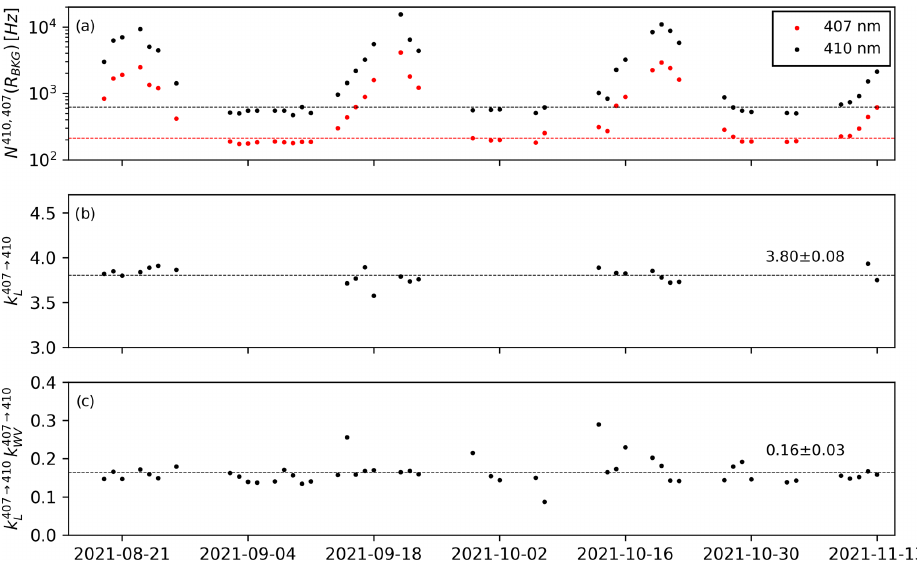
Figure 5. (a) Time series of background levels for the 407nm (red dots) and 410nm (black dots) channels. The average of the background levels for days where other unknown light sources dominate (low moonlight contribution) is also shown (dashed red and dashed black lines). (b) Time series of the 410/407nm channel background ratio (lidar spectral response ratio) calculated based on days where moonlight dominates and after subtracting the contribution from unknown light sources. The average of the lidar spectral response ratio is also shown (dashed black line). (c) Time series of the ratio between the 410/407nm channels for altitudes between 9–11kma.s.l., where the fluorescence contribution can be typically considered negligible (Eq. 6). The average is also shown (dashed black line).